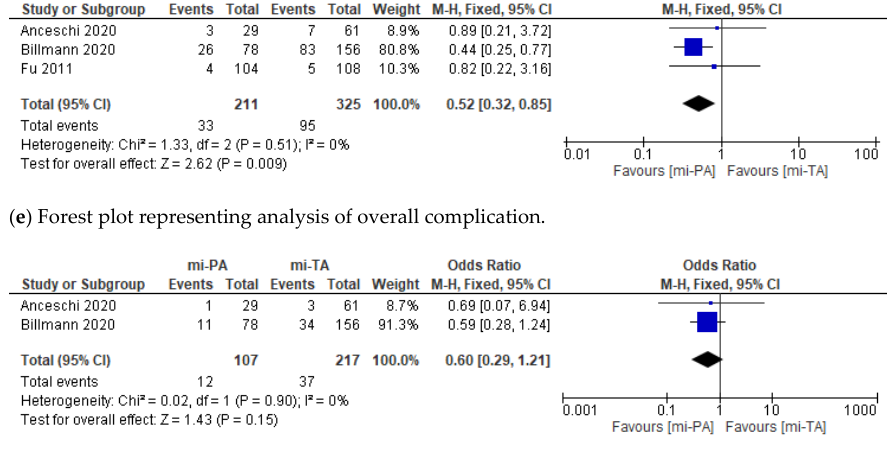
( f ) Forest plot representing analysis of complication Clavien Dindo ≥ 2. Figure 2. Cumulative analysis of eligible studies comparing mi-PA vs. mi-TA in terms of ( a ) operative time, ( b ) transfusion rate, ( c ) blood loss, ( d ) hospital stay, ( e ) overall complication, and ( f ) Clavien – Dindo ≥ 2. IV = inverse variance; SD = standard deviation; CI = confidence interval; M – H = Mantel – Haenszel. Each studies is represented by a square incorporating confidence intervals represented by horizontal lines. The area of each square is proportional to the study's weight in the meta-analysis. The meta-analysed measure of effect is plotted as a diamond with lateral points indicating confidence intervals. 3.3. Functional Outcomes According to PASO criteria, complete, partial, and absent clinical success analyzed over 324 patients from two series showed no differences [10,36]. Moreover, similar results were found when considering no-standardized complete and absent clinical success over five studies for a total of 720 patients included [10,11,34–36]. No differences in persistence of postoperative hypokalemia and improvement in HTN were reported between mi-PA and mi-TA. Only two recurrences, confirmed by radiological and clinical investigation, respectively, were reported in the whole cohort (Figure 3). ( a ) Forest plot representing analysis of patients with complete clinical success according to PASO criteria. ( b ) Forest plot representing analysis of patients with partial clinical success according to PASO criteria.